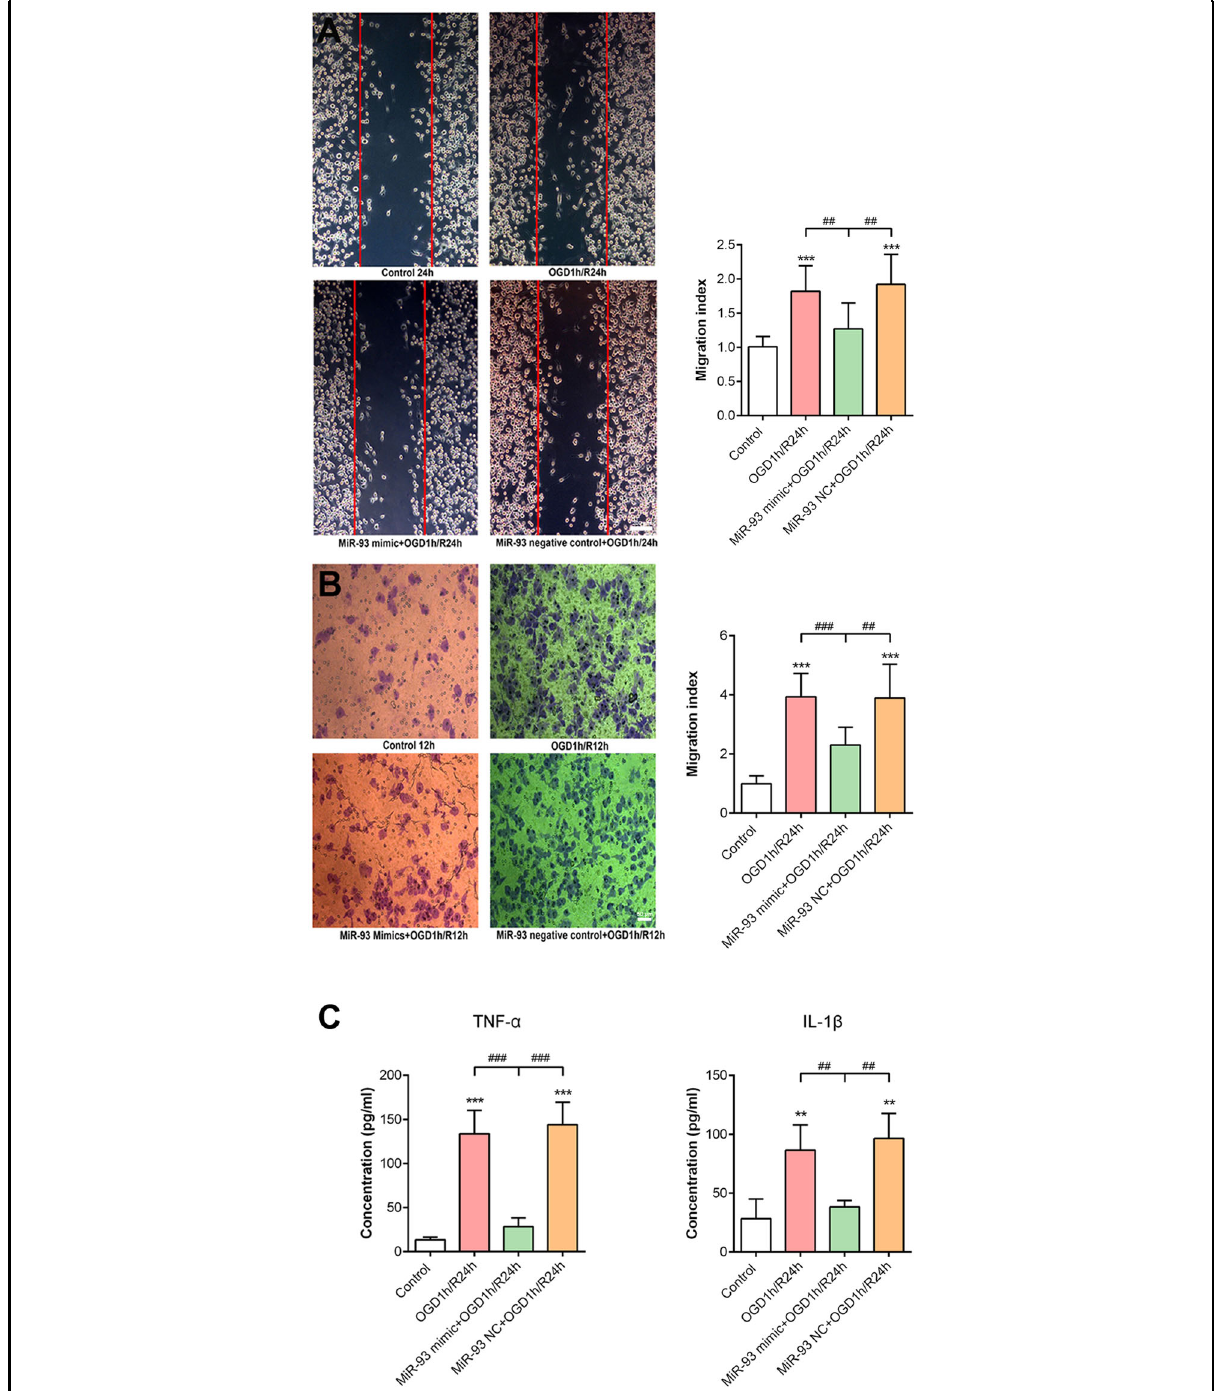
Fig. 5 Overexpression of miR-93 inhibited microglial migration and cytokine production after OGD1 h/R24 h. A , B The scratch test and transwell assay showed that microglial migration indices were markedly increased by OGD1 h/R24 h stimulus and were effectively reduced by miR-93 overexpression but not by NC transfection. C MiR-93 overexpression inhibited the OGD1 h/R24 h-mediated overproduction of TNF- α and IL-1 β by microglia cells, as measured by ELISA. Compared with the control: ** P < 0.01, *** P < 0.001. Compared with the OGD1h/R24h and miR-93 NC + OGD1h/ R24h group: ## P < 0.01, ### P < 0.001. n = 3 independent cultures. OGD1h/R24h, oxygen – glucose deprivation for 1 h and reperfusion for 24 h; NC, mimic negative